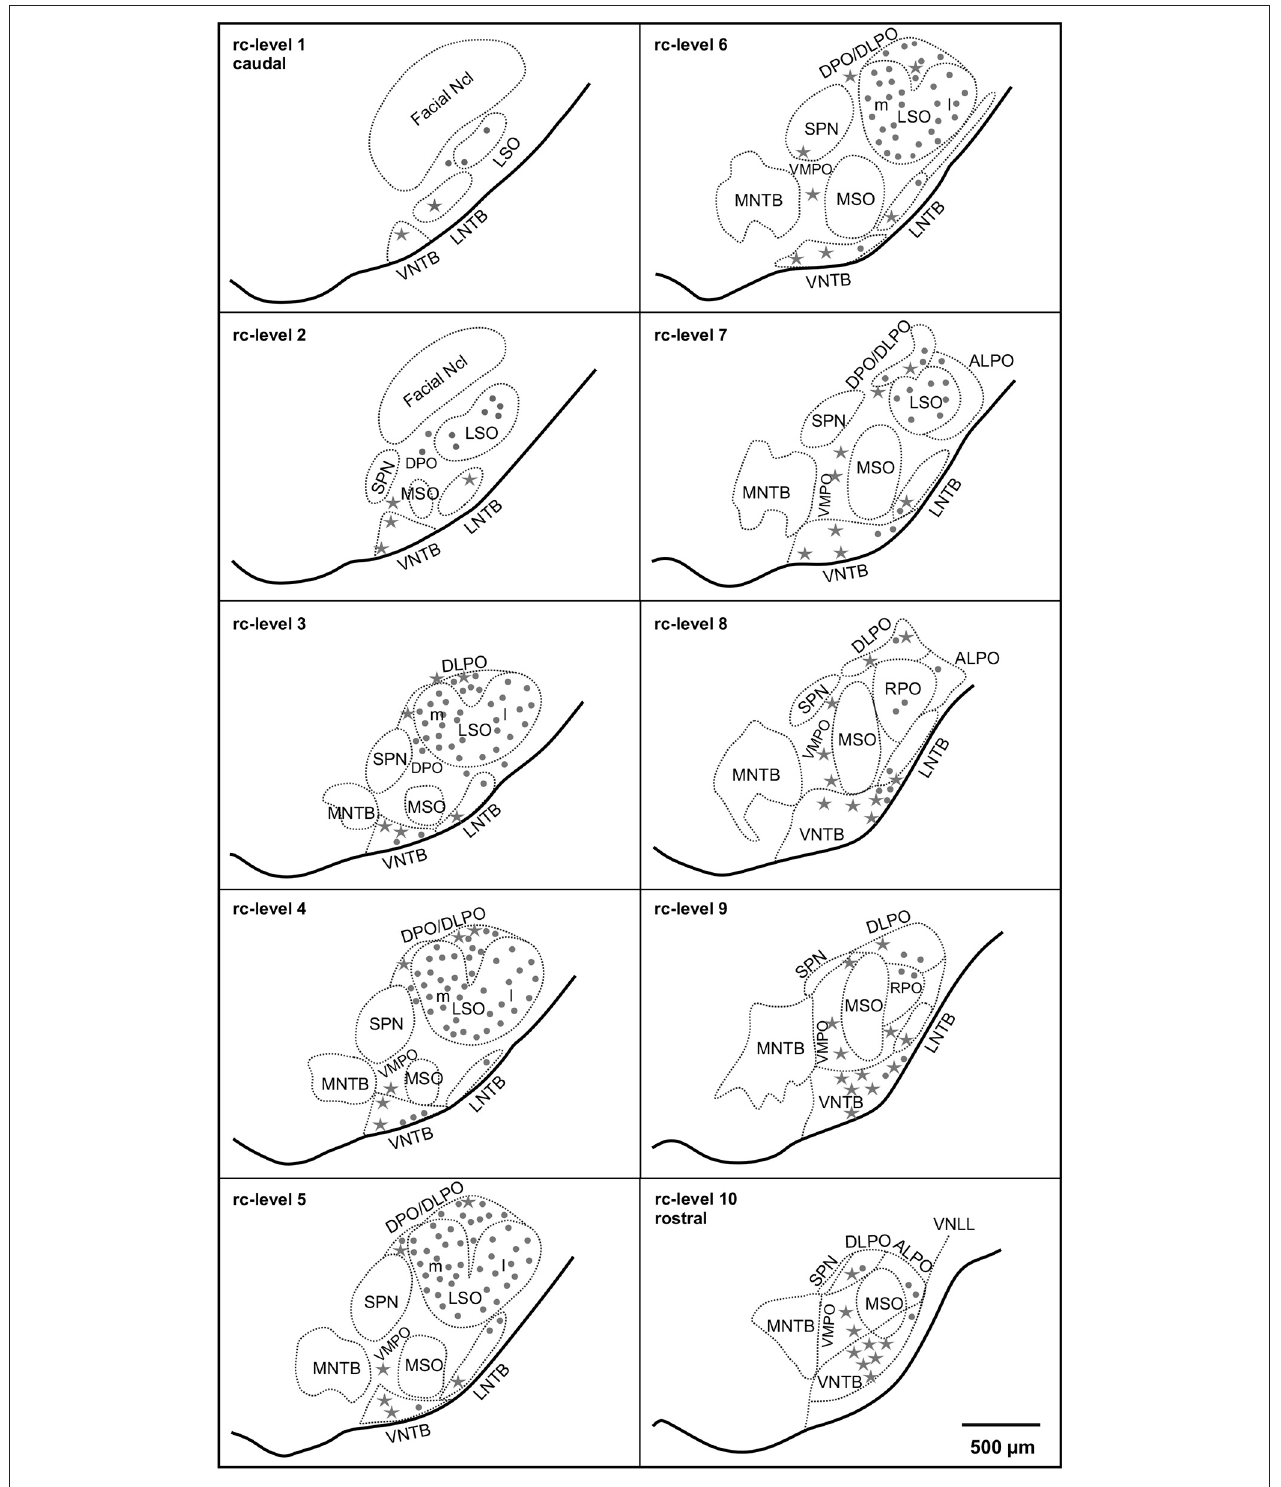
the most caudal and rc-level 10 the most rostral position. Dots: small cholinergic neurons comprising LOC neurons. Stars: large cholinergic neurons, including MOC neurons. The density of symbols represents roughly the relative frequency of occurrence of the respective cholinergic neurons within each